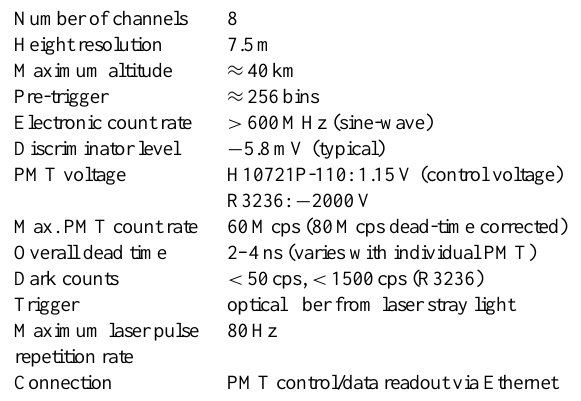
Table 3. Specification of the new CNT80 data acquisition hardware as applied in Polly XT .